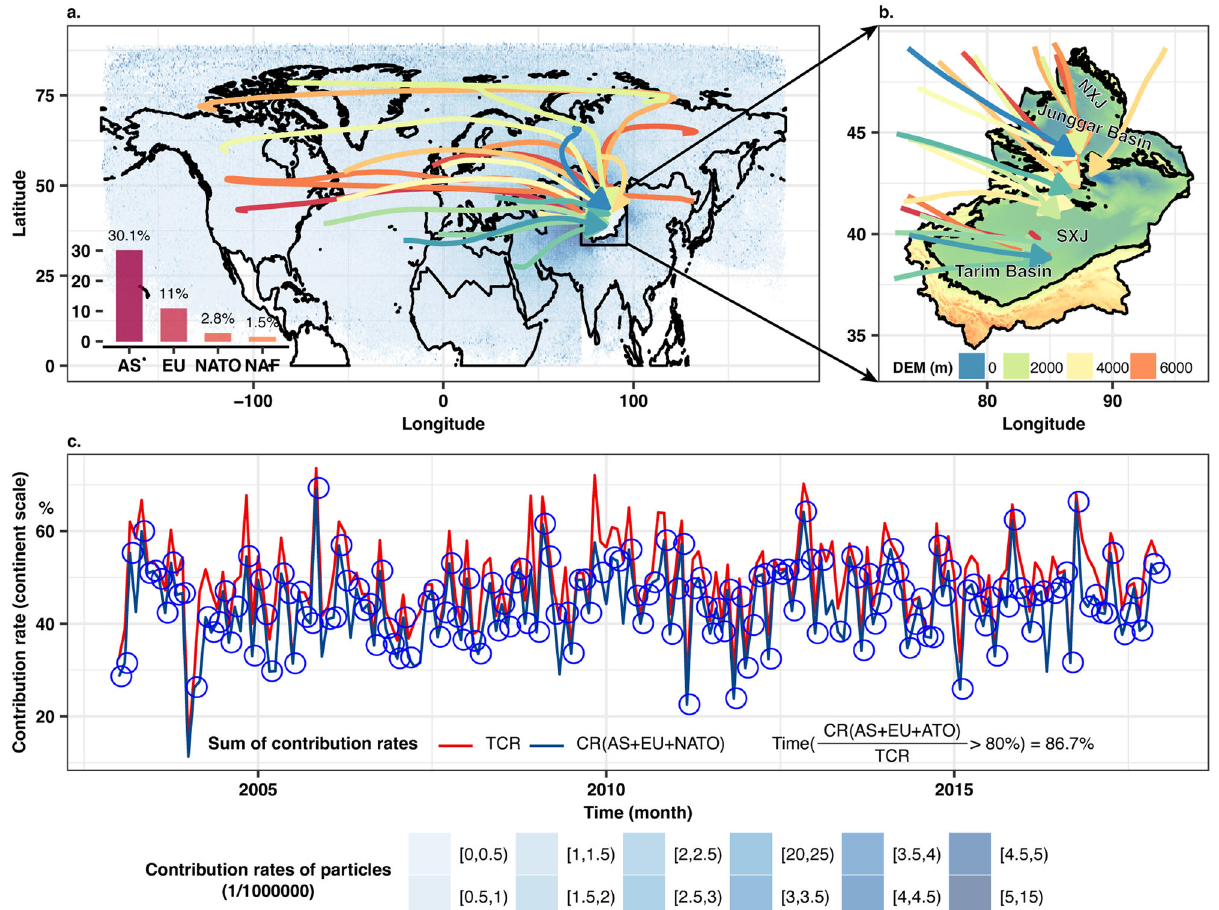
Fig. 1 Identi fi cation of the water vapor sources for Xinjiang, China. Contribution rates (CRs) of 500,000 water particles to the precipitation in Xinjiang during 2003 – 2017 by month, and cluster analysis of back traced trajectories of water particles ( a ). The routes of moisture trajectories and spatial pattern of terrain in Xinjiang ( b ). Temporal covariation of the total contribution rate (TCR) and the sum of CRs from Asia (AS), Europe (EU) and the North Atlantic Ocean (NATO) (CR(AS + EU + NATO)) during 2003 – 2017 ( c ). The time when CR(AS + EU + NATO)/TCR > 80% took account of 86.7% of the whole study period. The NXJ and SXJ refer to the north and south Xinjiang in the plot. The NAF in the subplot a refers to North